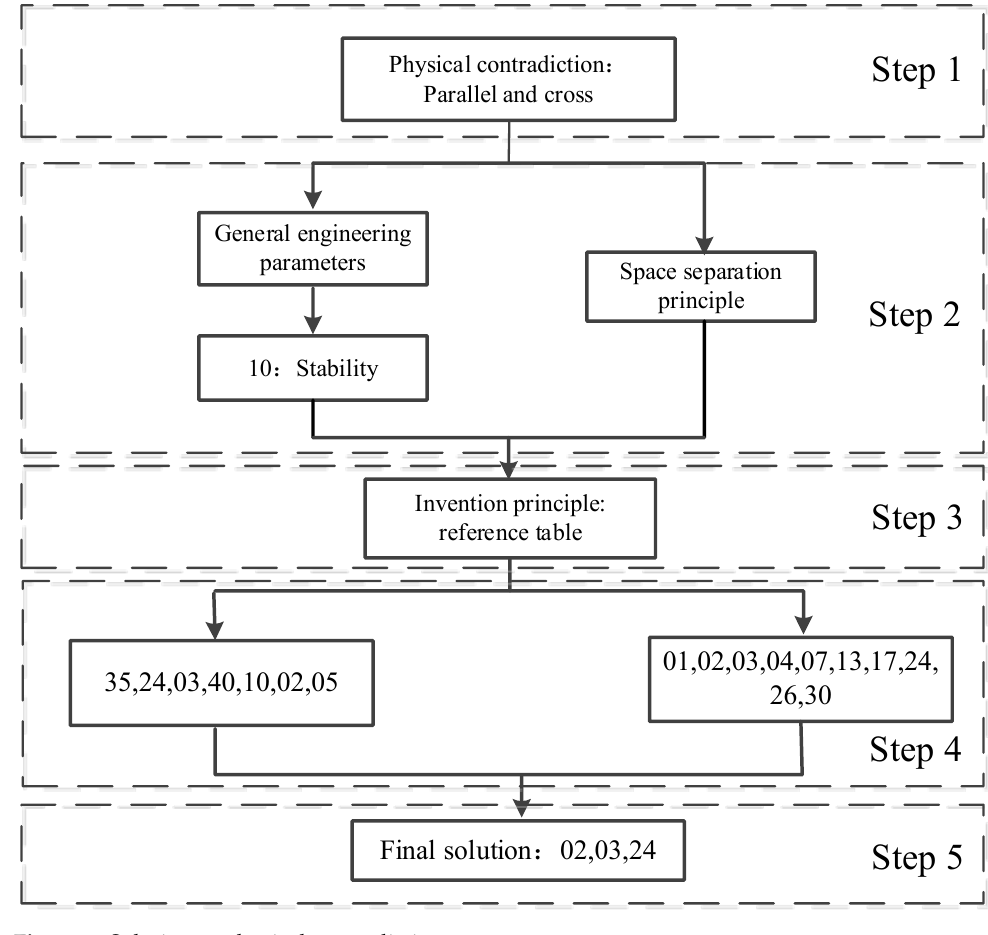
Figure 1. Solution to physical contradiction.